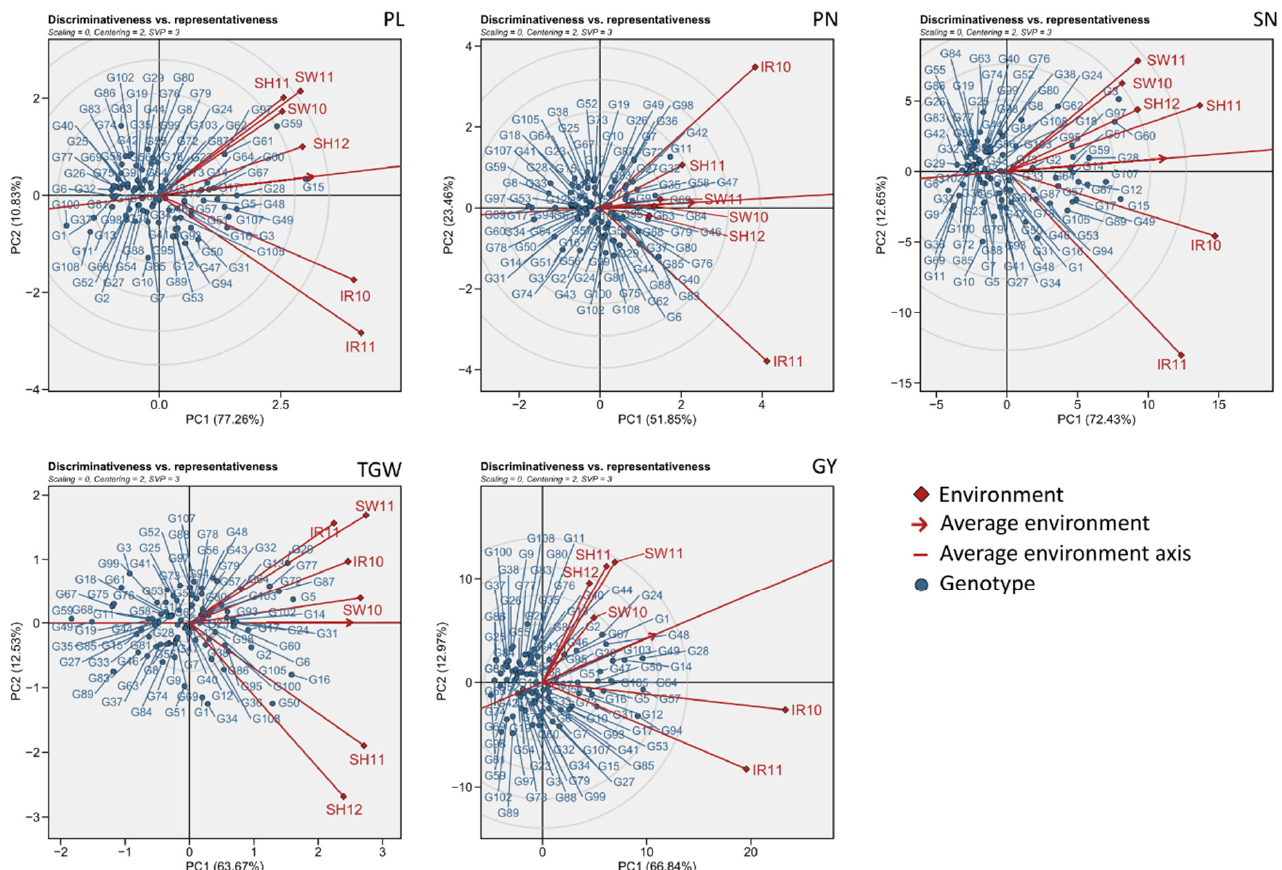
Figure 2. Discrimination and representativeness view of the genotypic main effects plus genotype by environment interaction (GGE) biplots based on yield-component traits and grain yield data of 89 genotypes in six environments. Red diamonds represent individual trials as location-year combinations. IR, IRRI, Los Baños; SH, Shanghai; SW, Suwon. Suffixes 10, 11, and 12 indicate trials in 2010, 2011, and 2012, respectively. The average environment for each plot is indicated with a red arrow. The average-environment axis (AEA) is indicated with a thick red line passing through the biplot origin and the average environment arrow. Blue circles show individual genotypes. PL, panicle length; PN, panicle number; SN, spikelet number per panicle; TGW, thousand-grain weight; GY, grain yield.